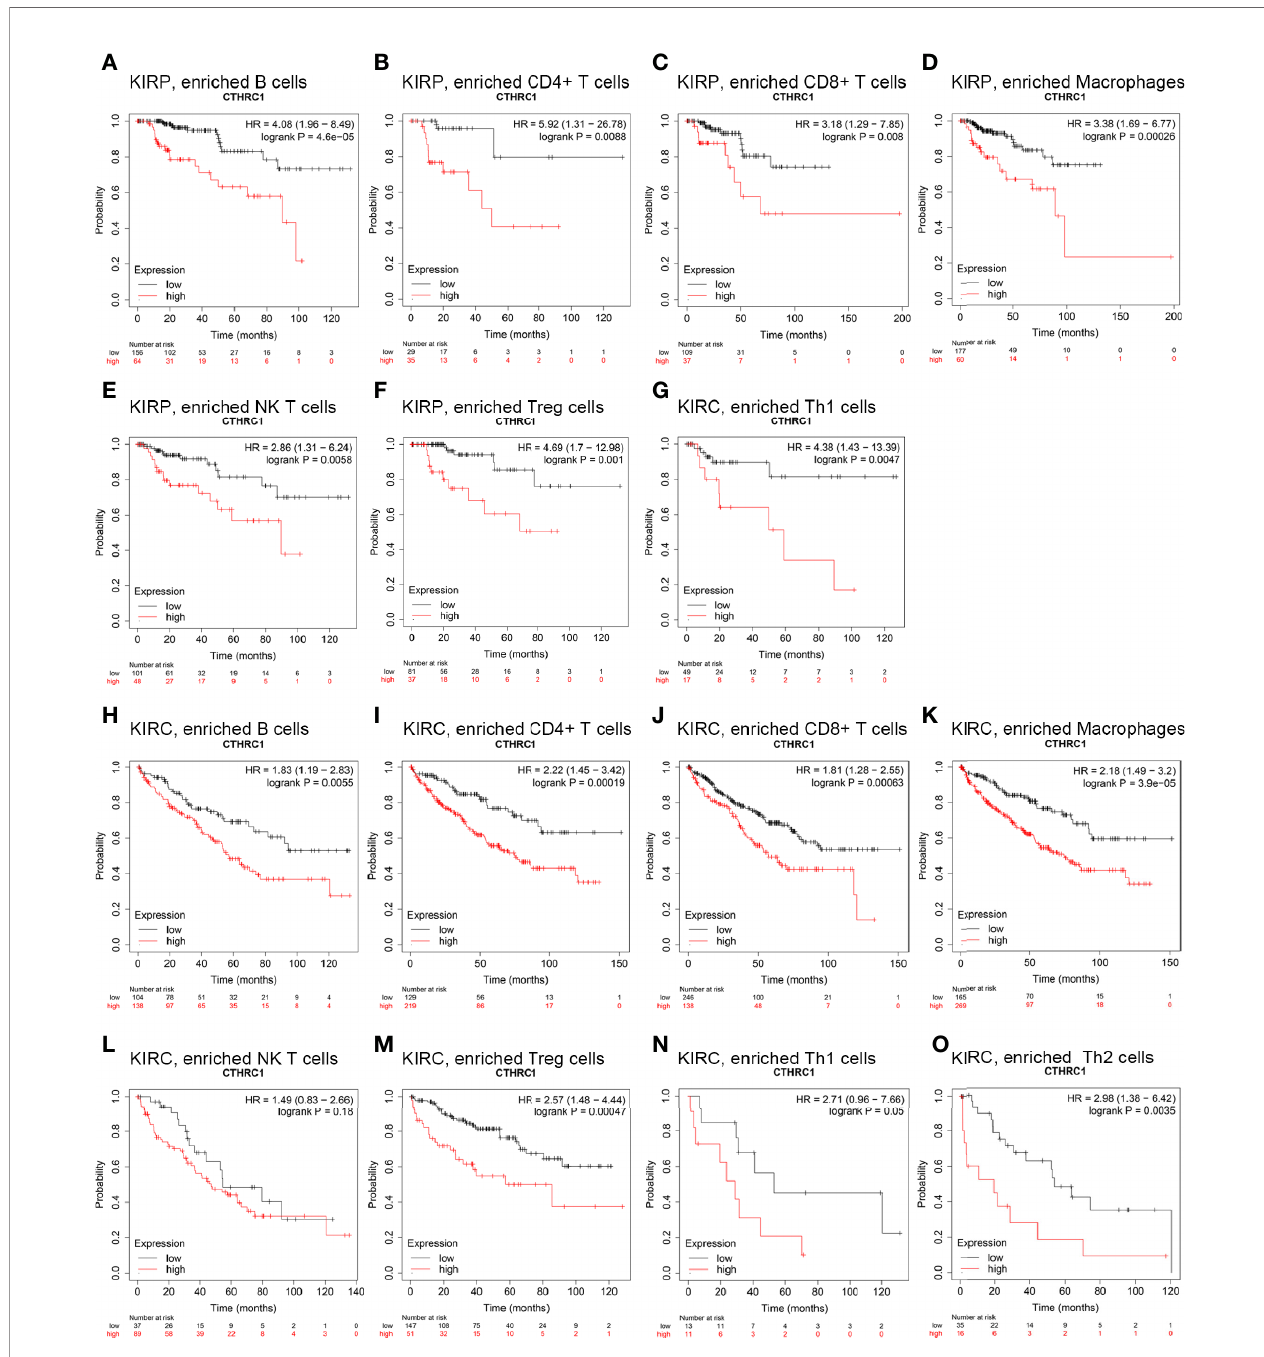
FIGURE 5 | Comparison of Kaplan-Meier survival curves of the high and low expression of CTHRC1 in KIRP and KIRC based on immune cells subgroups. (A – G) High CTHRC1 level enriched in B cells, CD4 + memory T cells, CD8 + T cells, macrophages, NK T cells, Treg T cells, Th1 cells had worse OS in KIRP. (H – O) Relationships between CTHRC1 of enriched in diverse immune and OS in